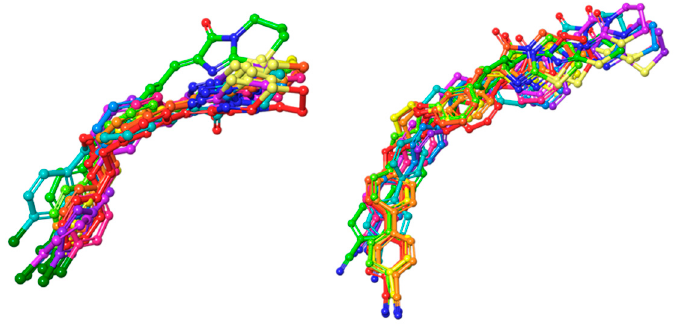
Figure 12. Examination of CB5 ( left ) and CB148 ( right ) compound stability in the binding pocket of the CF-DM model. Compound poses were captured at following frames: 0 ns—green; 1 ns—teal; 2 ns—blue; 3 ns—violet; 4 ns—magenta; 5 ns—pink; 6 ns—red; 7 ns—orange; 8 ns—light orange; 9 ns—yellow; 10 ns—lime. For a colored figure, please refer to the online version of this paper.